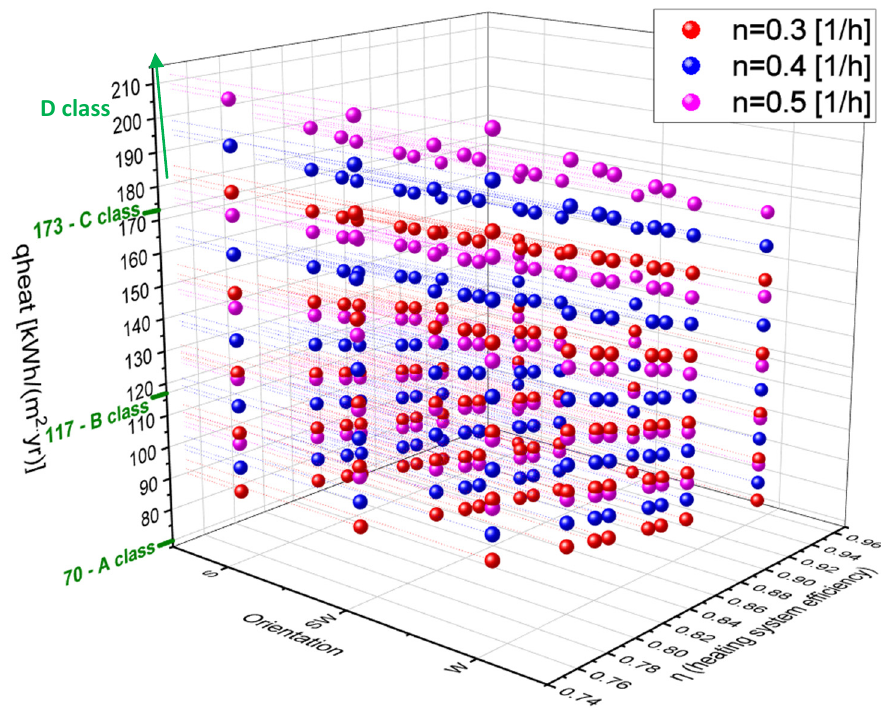
Figure 13. The energy consumption for heating for the 360 case scenarios. Table 8. Obtained minimum and maximum values for the heating energy consumption, q heat , and corresponding energy class for heating per climatic